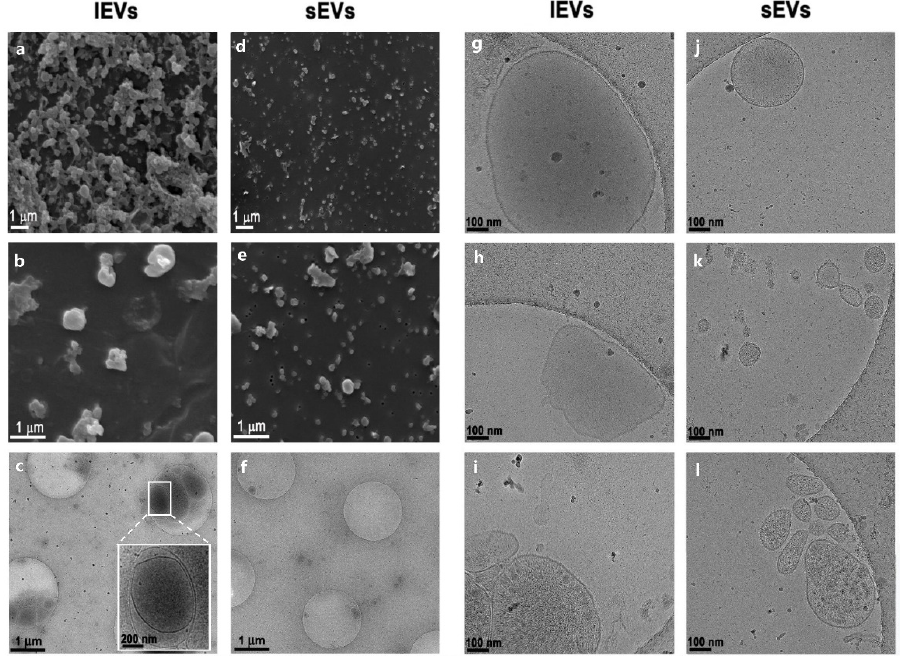
Figure 2. Analysis of NTERA2 cell-derived extracellular vesicles by electron microscopy. Scanning electron microscopy ( a , b , d , e ) and cryogenic transmission electron microscopy ( c , f , g – l ) images of large and small extracellular vesicle (lEV and sEV) preparations. Magnification bars are reported in each image.